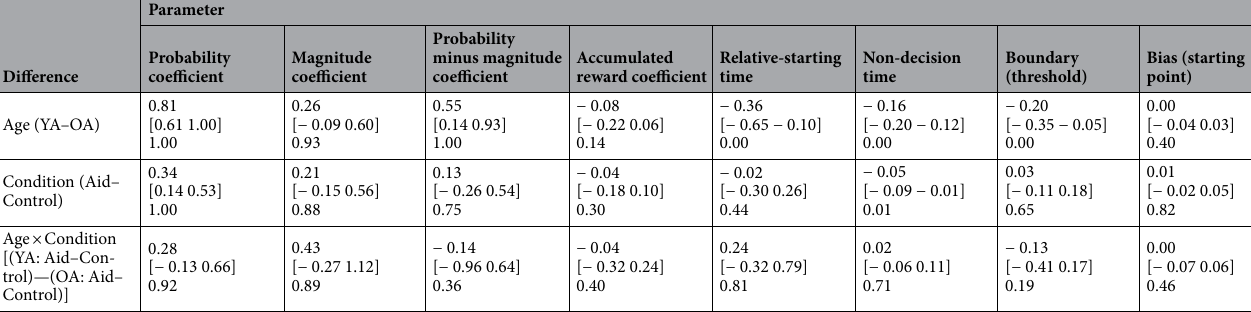
Table 3. Differences in the posterior distributions for each parameter of the best fitting model (M3) across age groups and conditions. This table reports the mean and 95% HDI in square brackets of the distribution of the differences in posterior estimates for each stDDM parameter. The posterior probability showing that the difference is greater than zero is listed below the HDI for each comparison. Posterior probabilities equal to 0.00 or 1.00 are due to rounding and do not indicate certainty. Abbreviations: HDI = highest density interval; PP = posterior probability; YA = younger adults; OA = older adults; Aid =